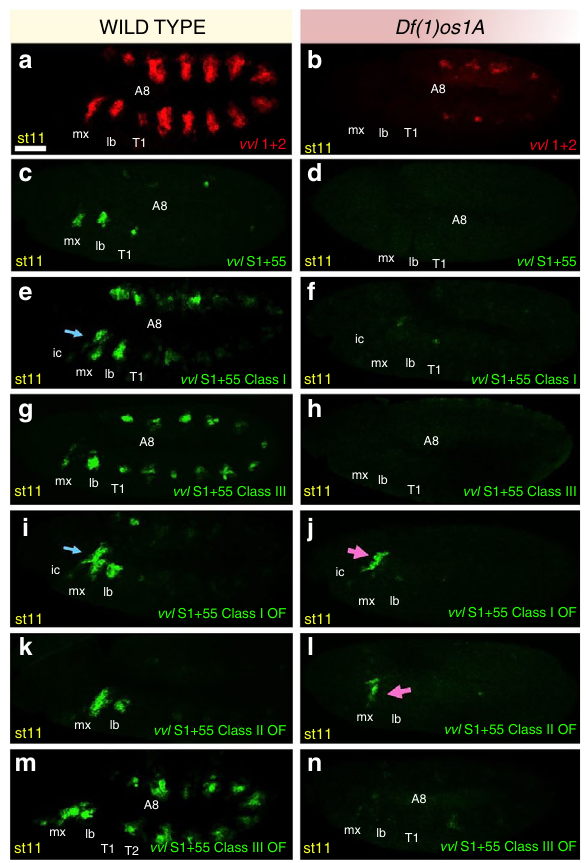
Fig. 6 Requirement of JAK/STAT signalling for vvl1 + 2 and S1 variants. Expression of vvl1 + 2 in wild type ( a ) and in Df(1)os1A embryos lacking all three JAK/STAT ligands ( b ). Expression of S1 + 55 in wild type ( c ) or in Df(1) os1A embryos ( d ). Expression of S1 + 55cl1 in wild type ( e ) or Df(1)os1A embryos ( f ). Expression of S1 + 55cl3 in wild type ( g ) or Df(1)os1A embryos ( h ). Expression of S1 + 5 5 cl1OF in wild type ( i ) or Df(1)os1A embryos ( j ). Expression of S1 + 5 5 cl2OF in wild type ( k ) or Df(1)os1A embryos ( l